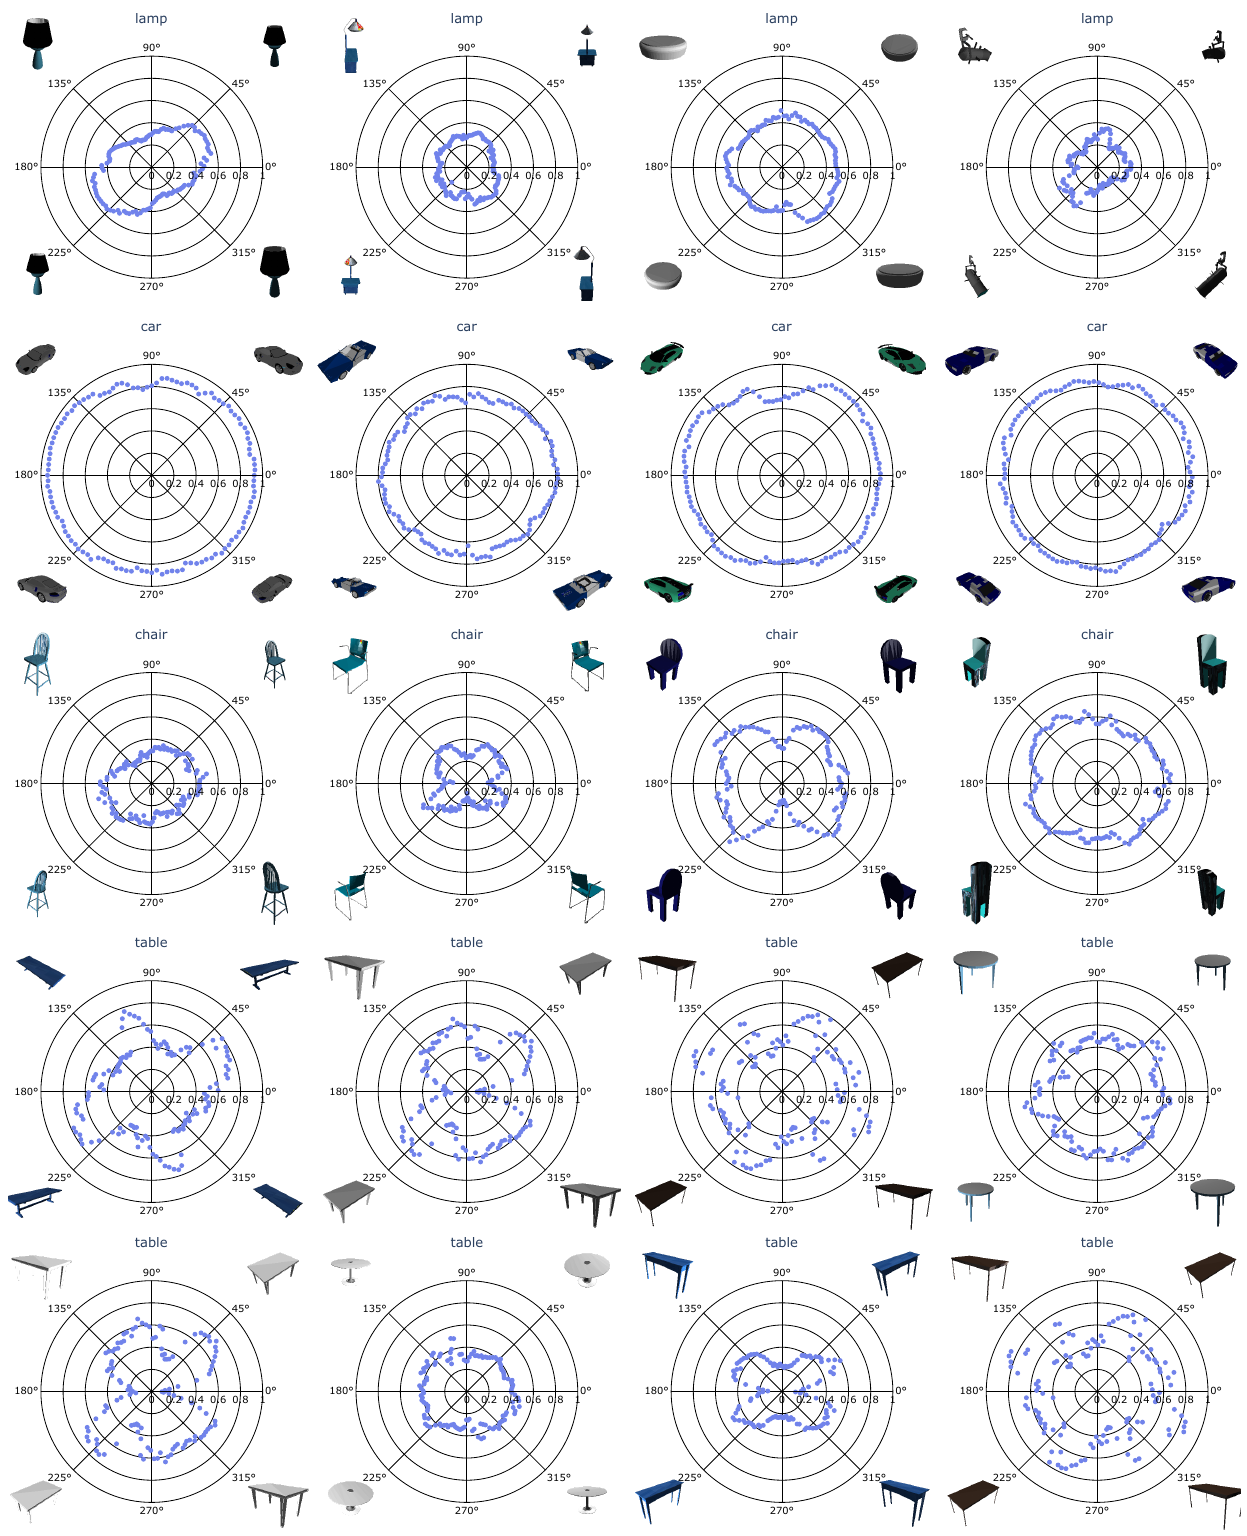
Figure A4. Extra polar-plot examples indicating single-view reconstruction quality. IoU is shown on the radial axis, viewpoint azimuth on the angular